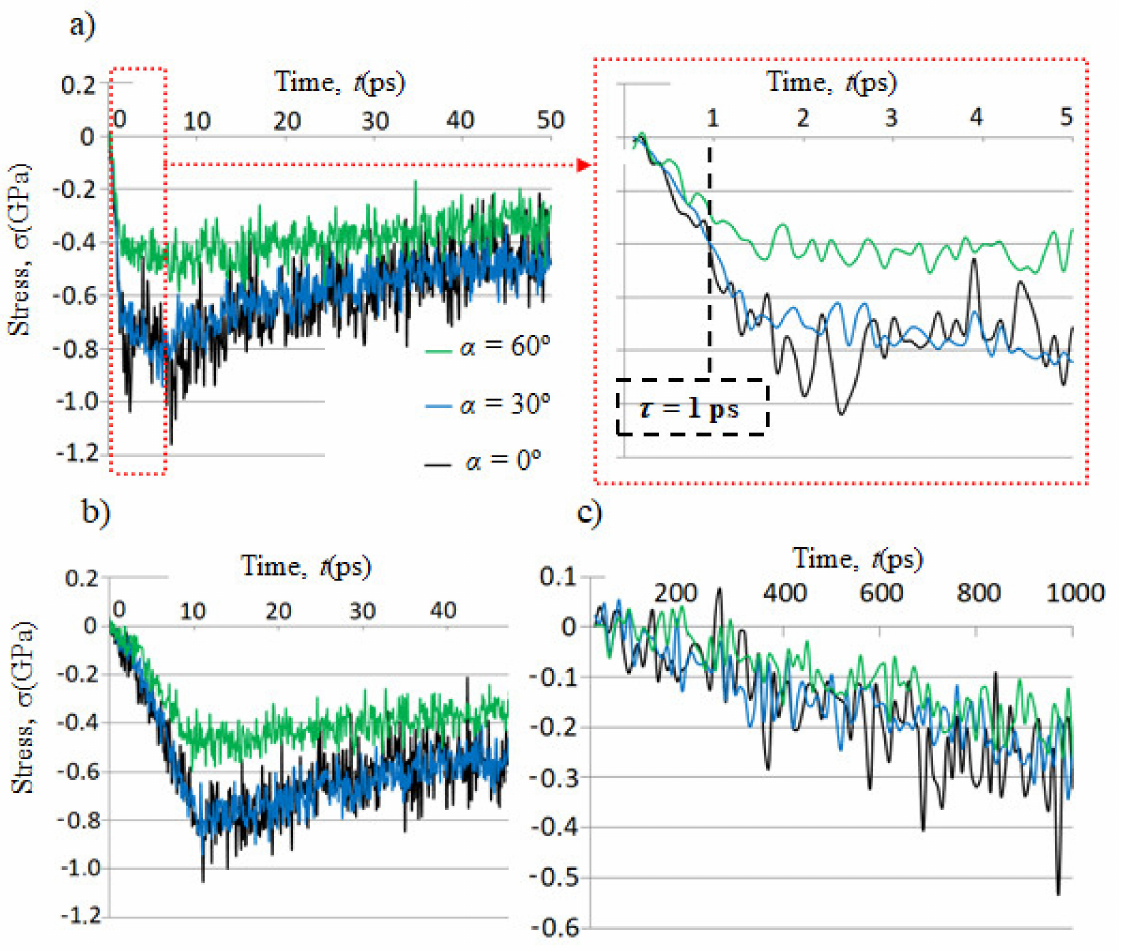
Figure 2. Heating-induced stresses in low-energy-deposited silicon dioxide films. Energy of the incoming silicon atoms E(Si) = 0.1 eV, α is the deposition angle, τ is the heating time, ( a ) τ = 1 ps; ( b ) τ = 10 ps; ( c ) τ = 1 ns. Heating temperature T f = 1300